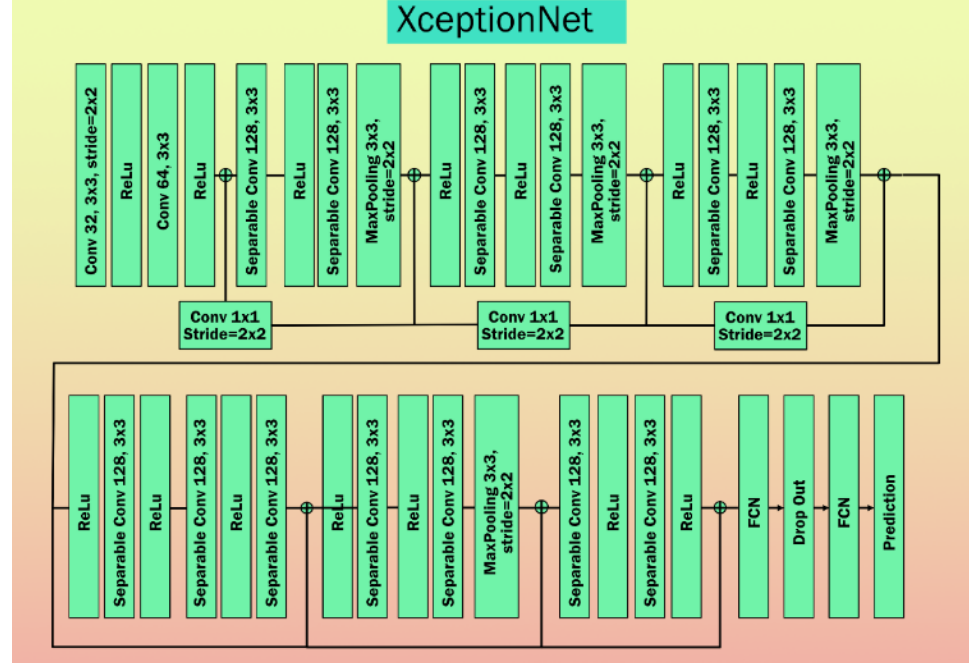
Figure 9. XceptionNet architecture.